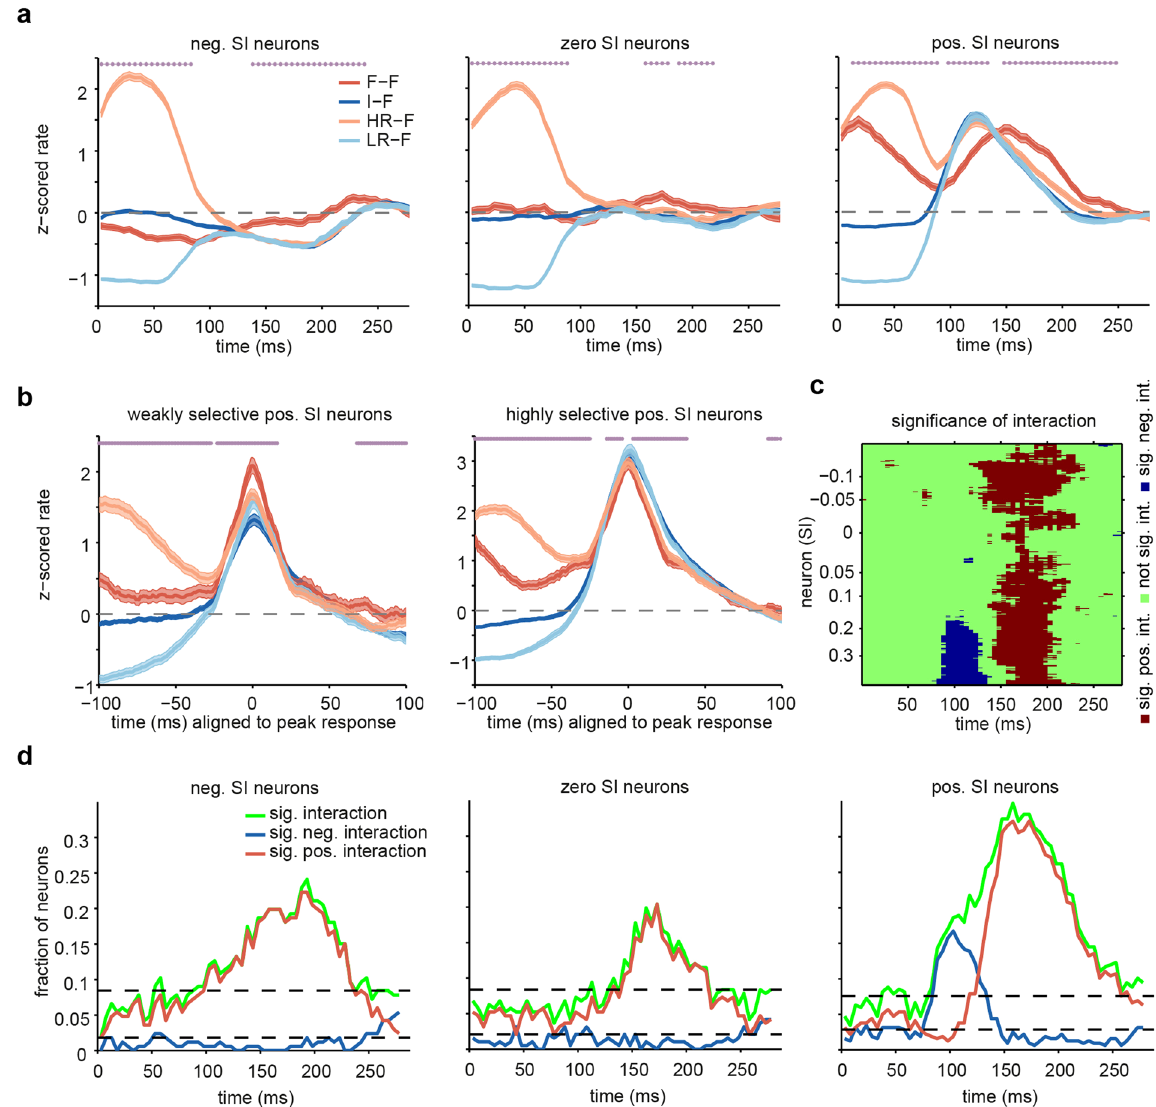
Figure 3. Effect of preceding stimulus rate and interaction of preceding and current stimuli on the activity of a population of IT neurons under the I-F and F-F conditions. ( a ) The time course of the averaged z-scored responses of three groups of neurons, which were defined based on the following SIs: neg. SI (SI < − 0.05), zero SI (0.05 < SI < 0.05) and pos. SI (SI > 0.05) neurons, which are shown from left to right. Each time course represents the response to face stimuli with different preceding stimuli: preceded by face (F-F, red), inanimate (I-F, blue), high rate (HR-F, pale red), and low rate (LR-F, pale blue). The stars show the significance of a paired t-test between the F-F condition and all other conditions (p < 0.05). ( b ) The z-scored responses of weakly and highly selective pos. SI neurons are aligned to their peak times. Weakly and highly selective neurons were obtained by dividing pos. SI neurons into two groups of equal size. The stars show the significant difference between the F-F and I-F conditions (paired t-test, p < 0.05). ( c ) The significance pattern of interaction across a 51 neuron subpopulation estimated by a generalized linear model (GLM). Red: positive, blue: negative and green: non-significant interaction. Similar to Fig. 1d, each row represents a 51 neuron subpopulation, and the value on the ordinate is the average of SIs for those neurons. The threshold for p-values is FDR corrected for multiple comparisons. ( d ) The fraction of neurons that show significant interaction between preceding and current stimuli at each time point are shown for the three following neuronal groups: neg. SI, zero SI, and pos. SI neurons, from left to right. The GLM is fitted at each time bin across trials of each neuron. The fraction of neurons with positive interaction (red) and negative interaction (blue) are shown separately, while the total fraction is indicated in green. The black dashed lines show a 95% confidence interval for the chance level computed by a binomial test (p =